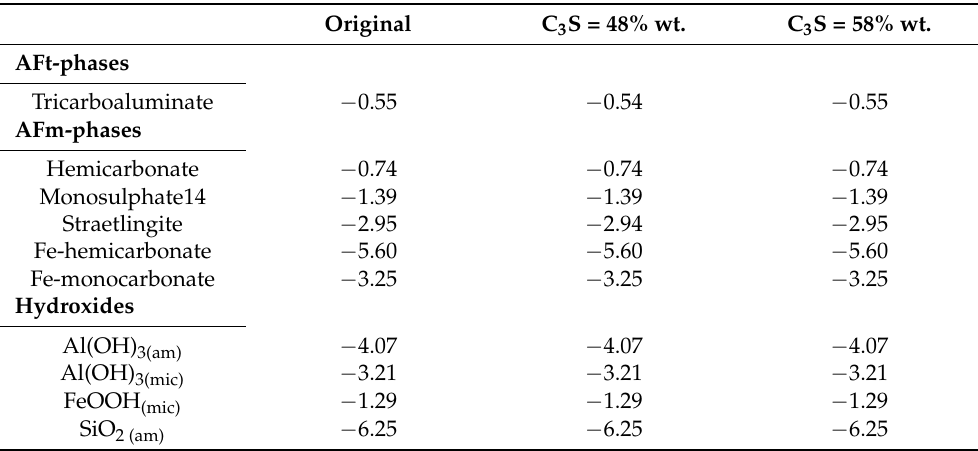
Table 2. Phase stability. Saturation index of the phases excluded in the system for three scenarios: the original oxide composition (original), an oxide composition with a lower C 3 S content (C 3 S = 48% wt.), and an oxide composition with a higher C 3 S content (C 3 S = 58% wt.). Phases with a negative saturation index are not expected to